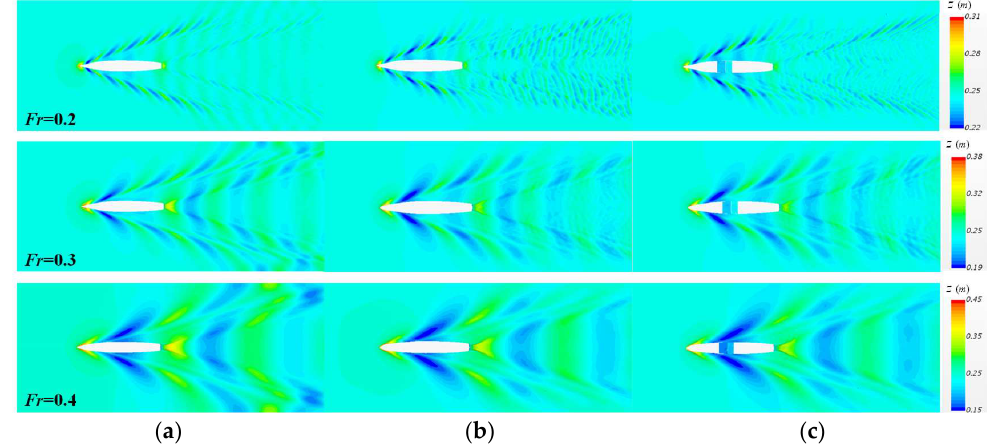
Figure 15. Comparison of wave patterns in different cases: ( a ) Intact case; ( b ) Damage-repaired case; ( c ) Symmetrical flooding case.